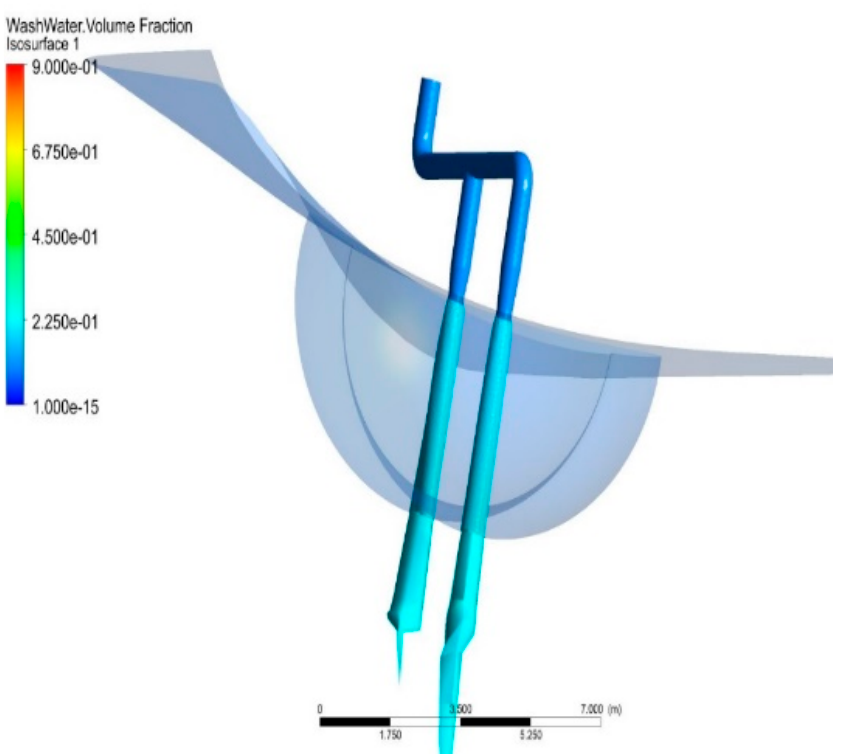
Figure 13. Scrubber Wash Water Volume Fraction of 0.1 isosurface development.